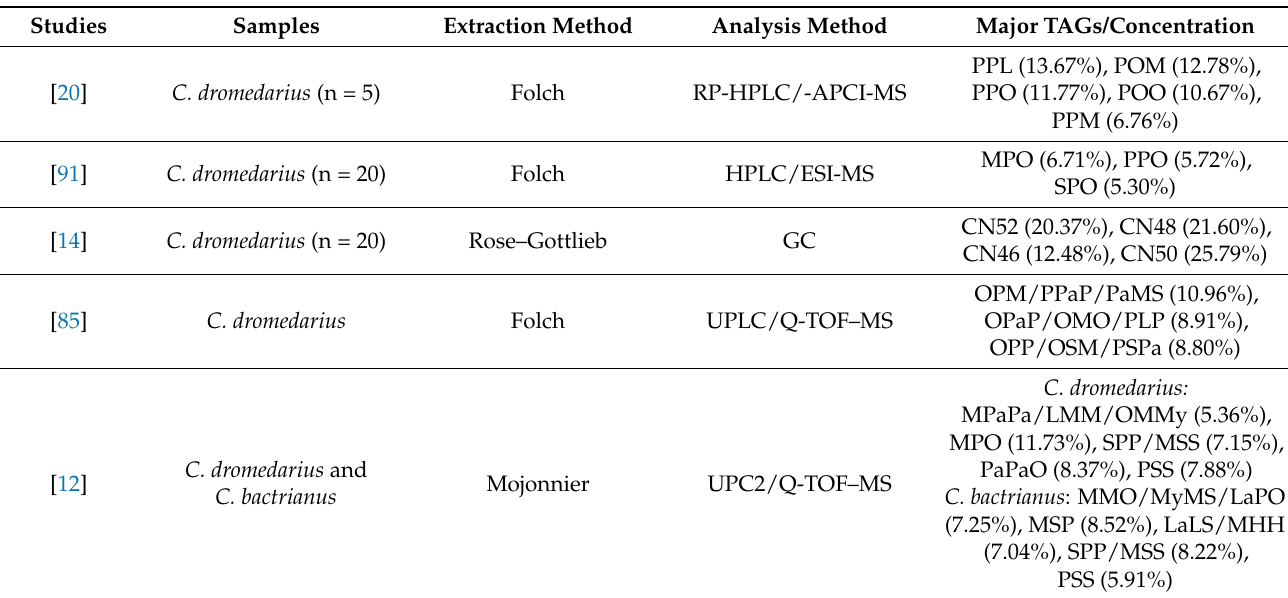
Table 4. Quantitative analysis of triacylglycerols in camel milk